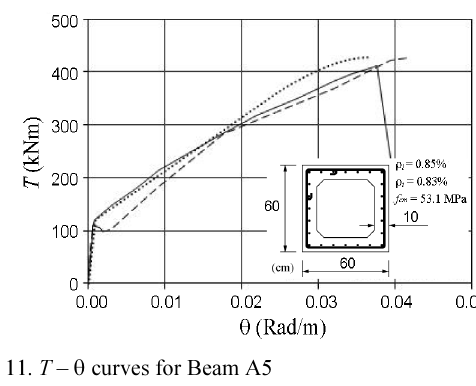
Fig. 14. T – θ curves for Beam B4